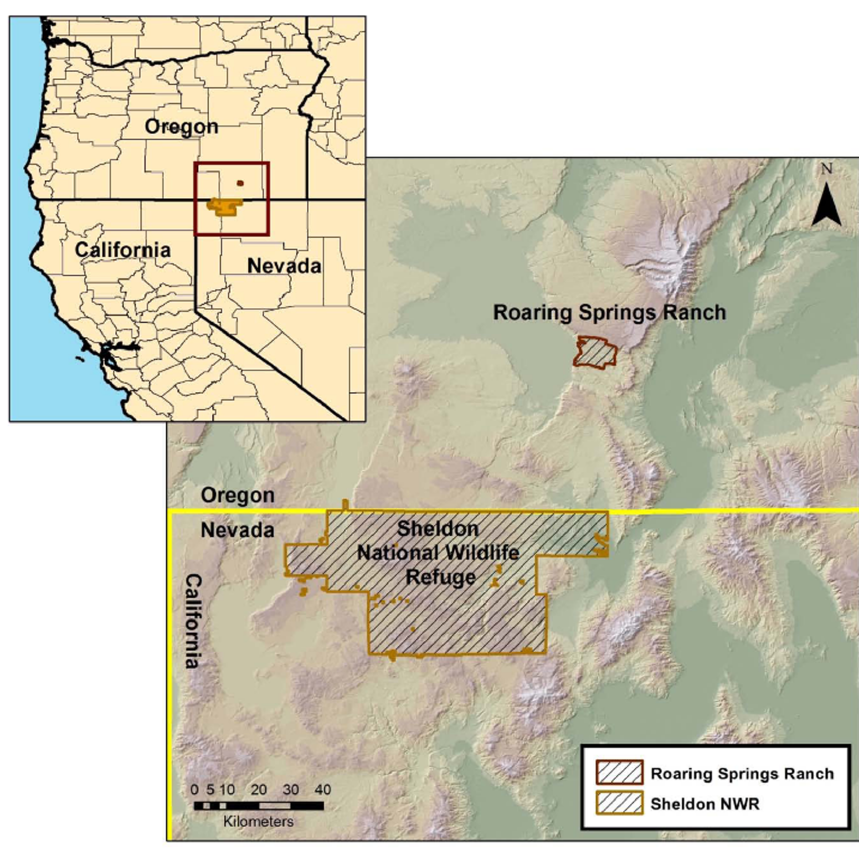
Figure 1. Pilot and in-field study site locations. The Roaring Springs Ranch (pilot study) is located in southeast Oregon. The Sheldon National Wildlife Refuge (in-field study) is located in northwestern Nevada.